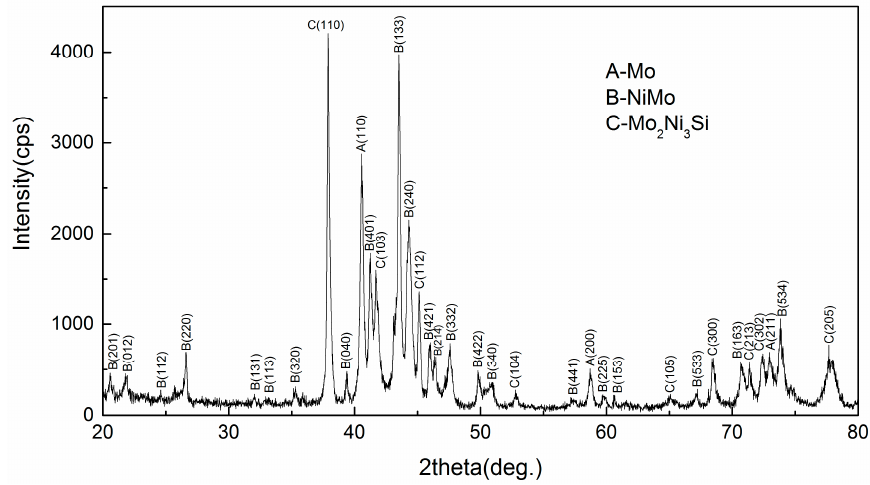
Figure 2. XRD profiles of the Mo–40Ni–13Si alloys.